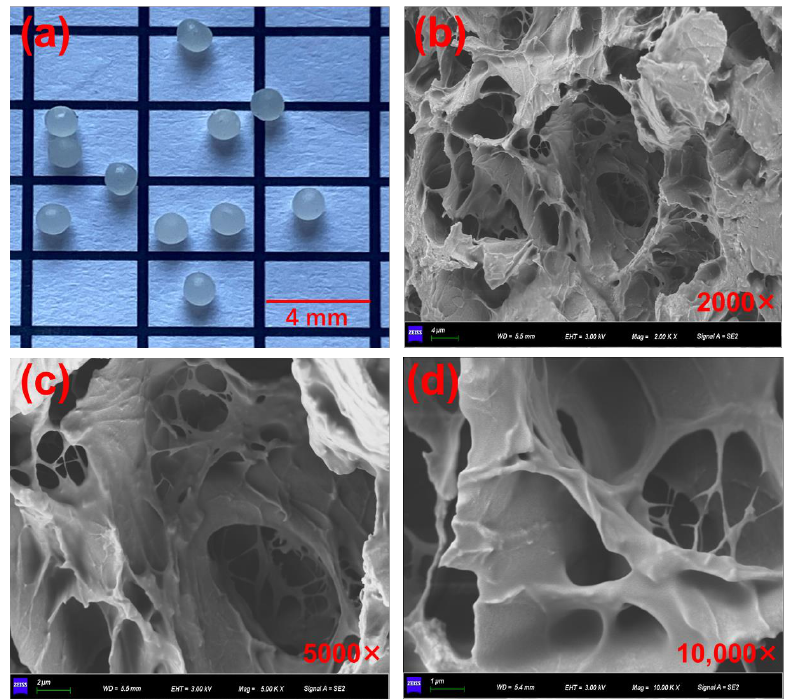
Figure 6. ( a ) Appearance of calcium alginate capsules and ( b – d ) the interior structure of the capsules with different magnification times.